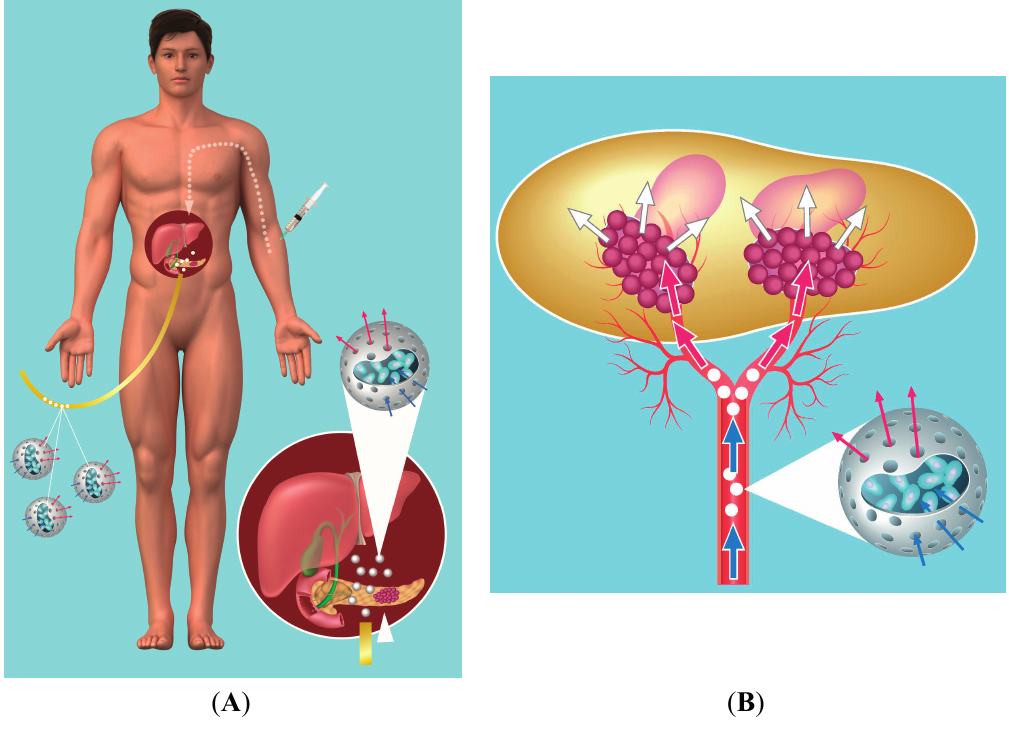
Figure 1. ( A ) schematic of placement of capsules in vessels leading to the pancreatic tumor using supraselective angiography with a catheter being inserted into a vessel in the groin, followed by low-dose ifosfamide administration given intravenously (IV); ( B ) schematic of ifosfamide (prodrug) conversion by encapsulated cells. Ifosfamide (blue arrow) delivered systemically enters the porous capsules and penetrates the encapsulated cells, where it is converted by the cytochrome P450 enzyme to its active form (red arrow). The short-lived activated ifosfamide (white arrow) exits the cells and leaves the capsules to bathe the